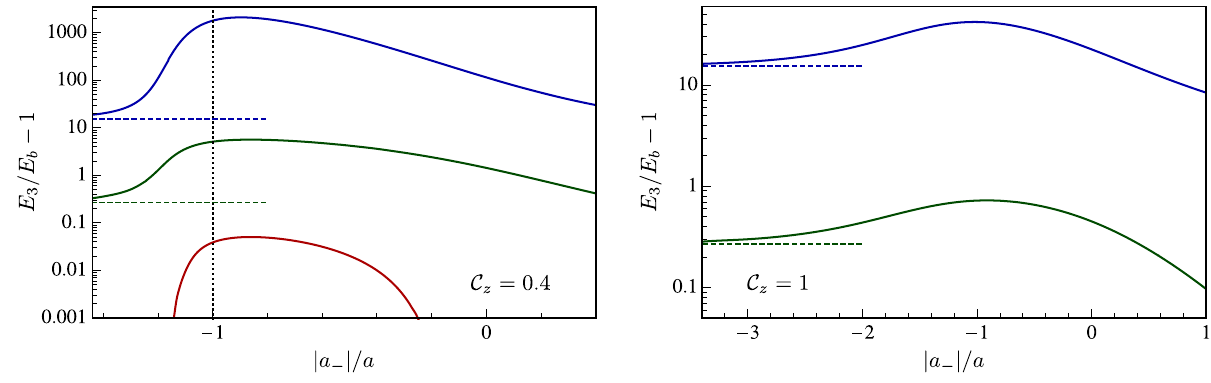
FIG. 3. Ratio between q2D trimer and dimer energies. The trimer energies (solid lines) are displayed as a function of interaction for ¼ 0 . 4 (left panel) and C ¼ 1 (right panel). In the limit j a j =a ≲ − 1 , the trimer energies converge to the two different confinements: C − z z j and − 1 . 27 j E j [12] (dashed lines). For moderate confinement (left panel), we see evidence of an avoided universal 2D results − 16 . 5 j E b b crossing resulting from the coupling between three “ bare ” states: the two 2D trimers, and a third trimer that emerges from the continuum at a ≃ a − (vertical dotted